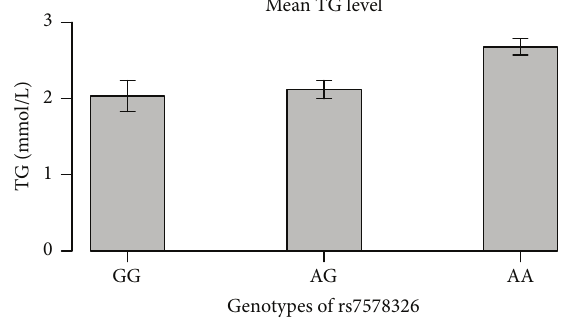
Figure 1: Correlation of mean triglyceride level with the geno- types of rs7578326 in the Mongolian sample. 𝑦 -axis represents TG (mmol/L) level, and 𝑥 -axis represents samples with different genotypes. Error bar represents standard error of TG in the samples with the specific rs7578326 genotype. Number of samples with genotypes GG, AG, and AA are 47, 248, and 647, respectively, across all samples including T2D cases and